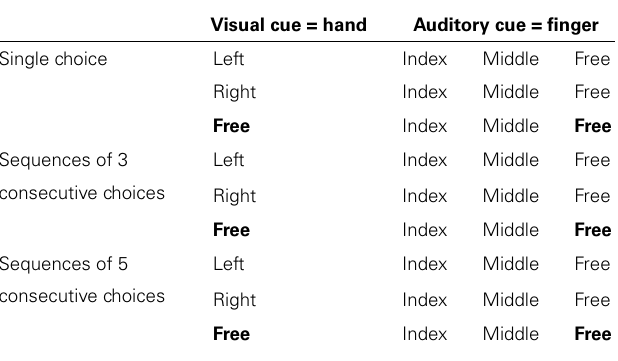
Table 1 | Experimental conditions in the free action generation task. Visual cue = hand